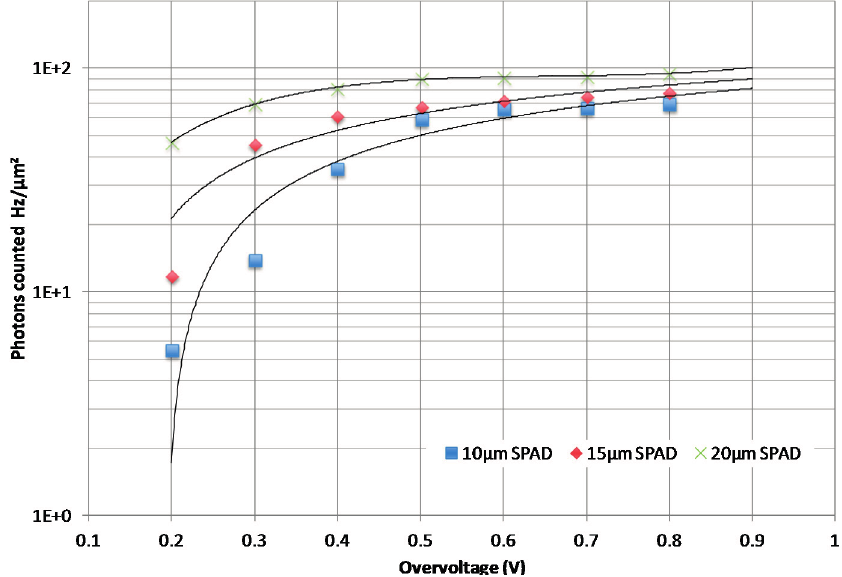
Figure 8. Number of photons counted per area unit as a function of